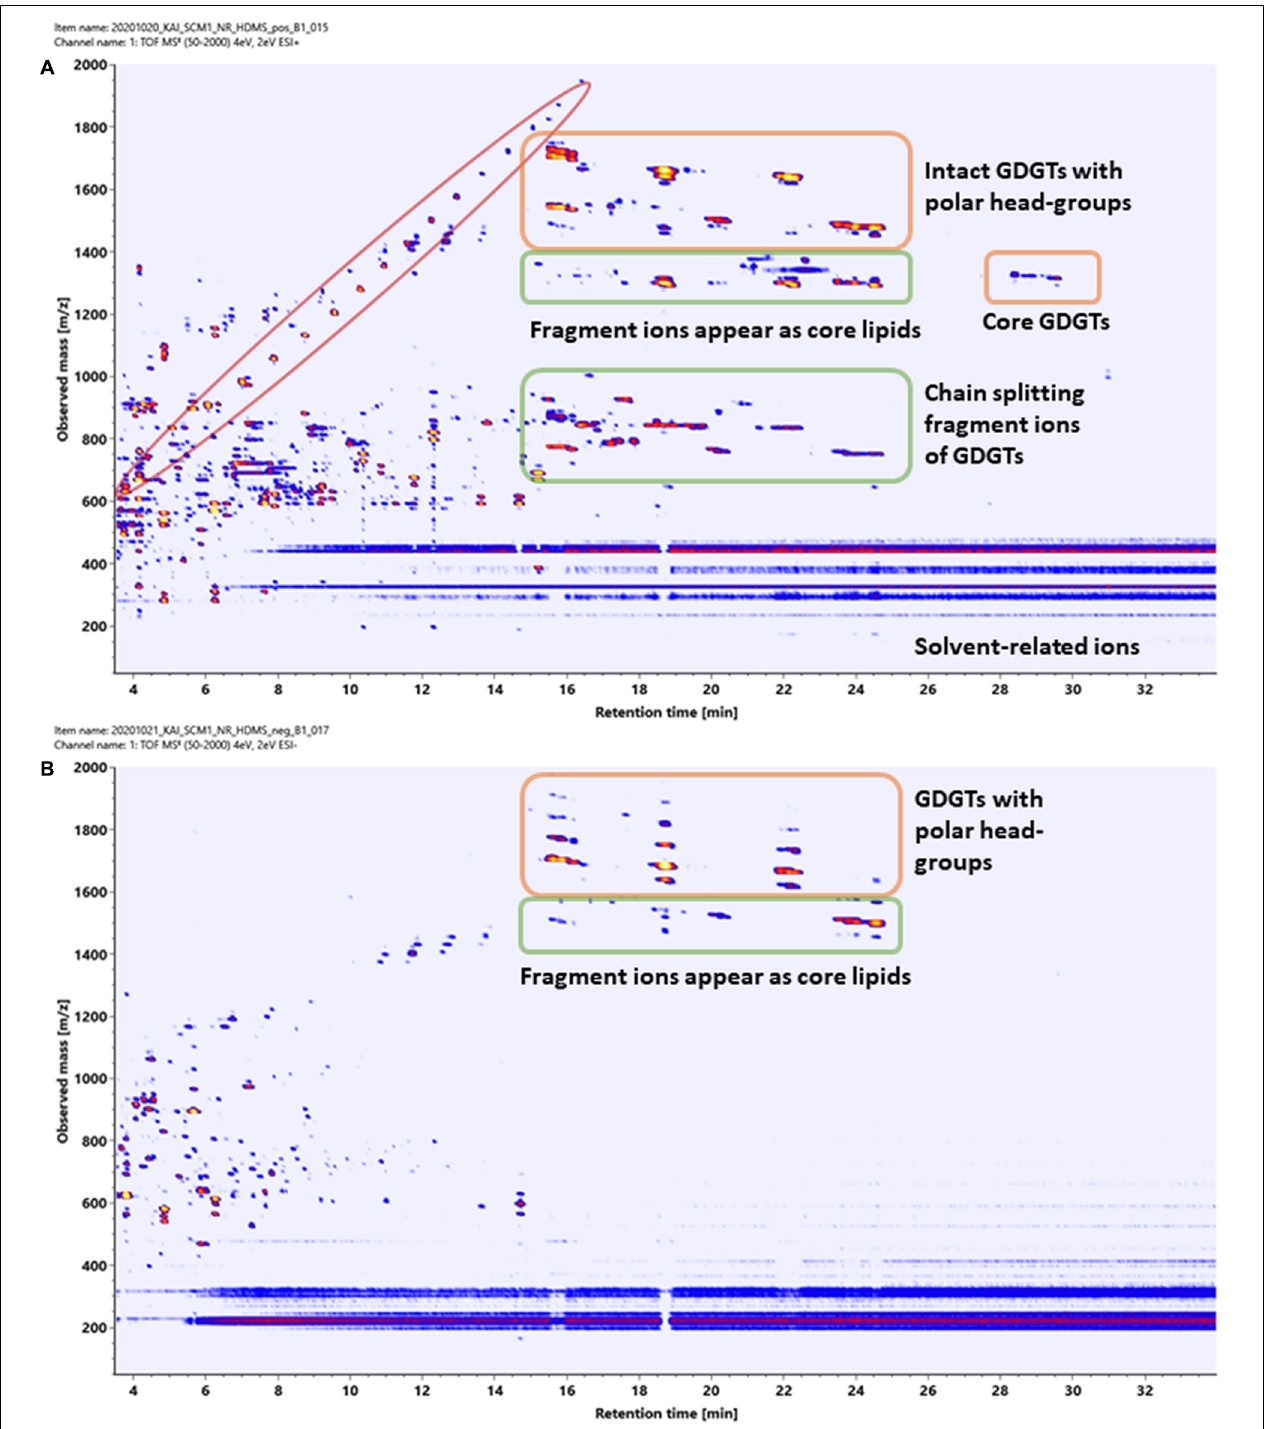
FIGURE 8 | Density maps ( mz -rt plots) of an experimental cellular lipid extract acquired in (A) positive and (B) negative ionization modes. In positive mode, in-source fragmentation of intact polar GDGT lipids generated core GDGT lipids as well as other fragment ions. Care should be taken to avoid misannotation. In negative mode, only adduct ions of intact polar GDGT lipids were observed. Polymer ions formed a diagonal group whereas solvent-related background ions appeared as horizontal bands.